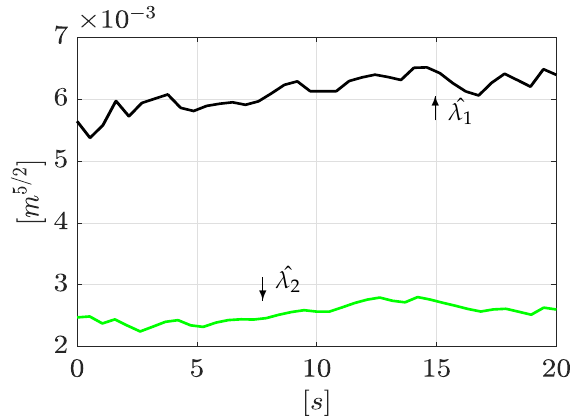
Figure 11. Estimation of leak magnitudes (2nd experiment).